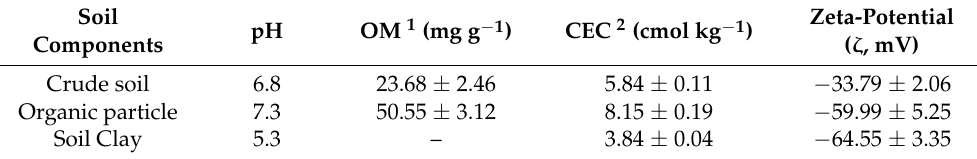
Zeta-Potential ( ζ , mV)